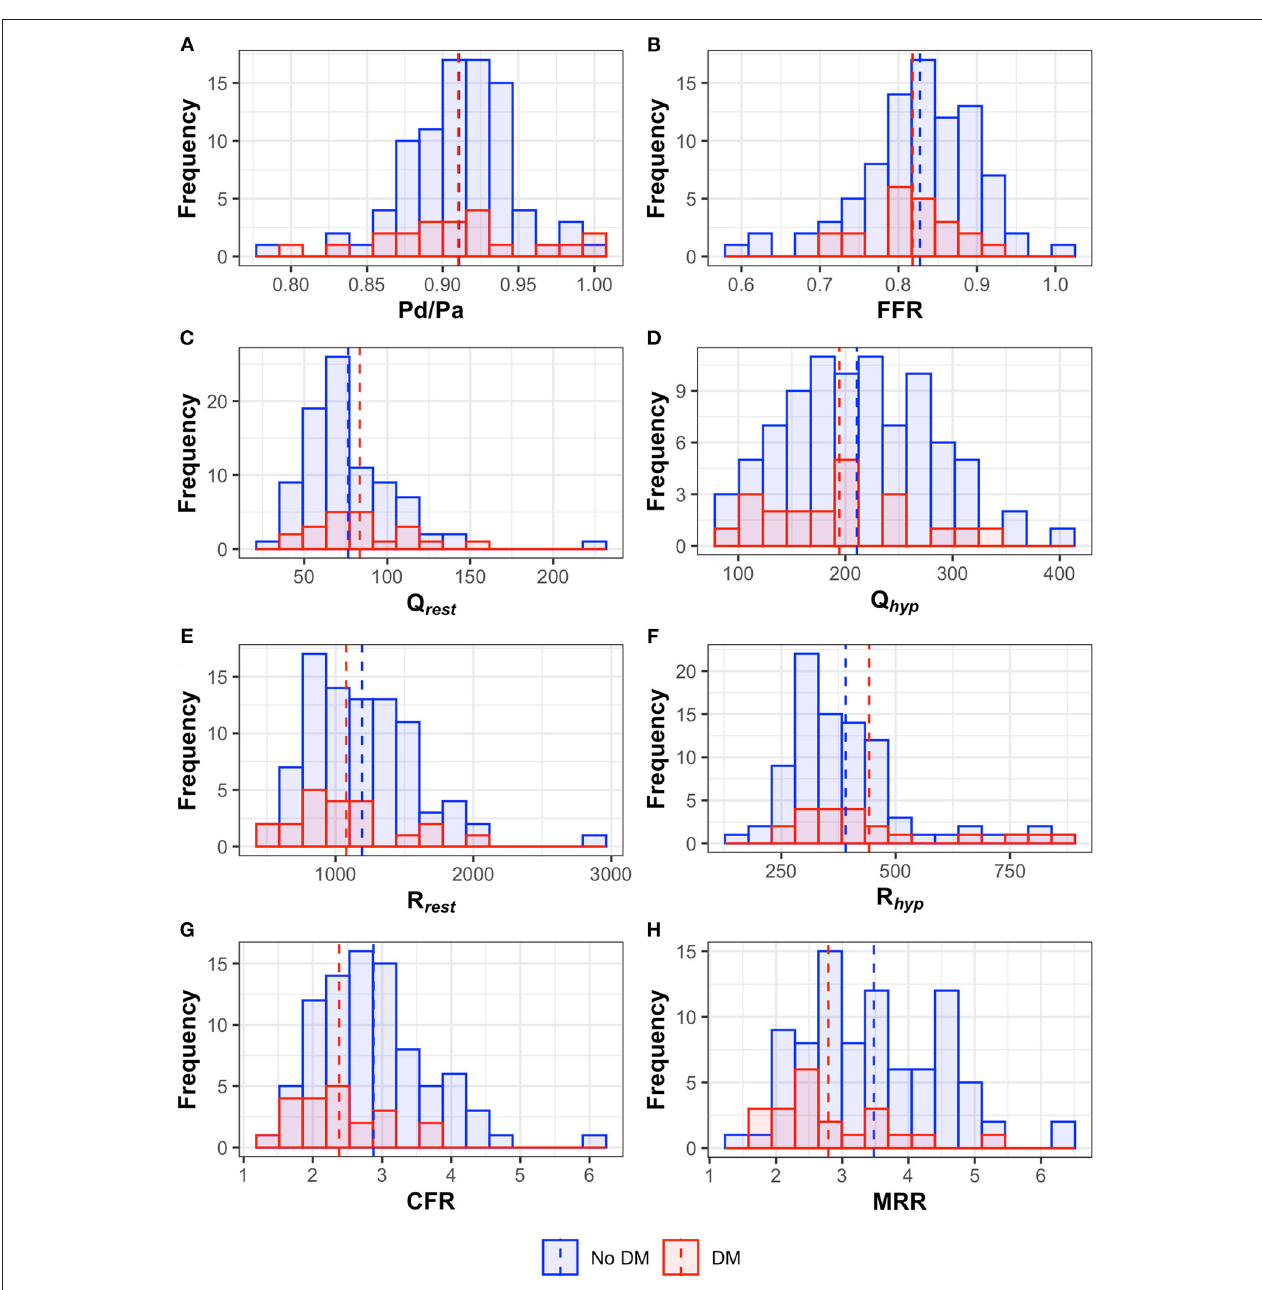
FIGURE 3 | Histograms and median values (dotted line) of the hemodynamic parameters [ (A) Pd/Pa, (B) fractional flow reserve – FFR, (C) resting flow, (D) hyperemic flow, (E) resting resistance, (F) hyperemic resistance, (G) coronary flow reserve – CFR, (H) microvascular resistance reserve – MRR] in both diabetic and non-diabetic